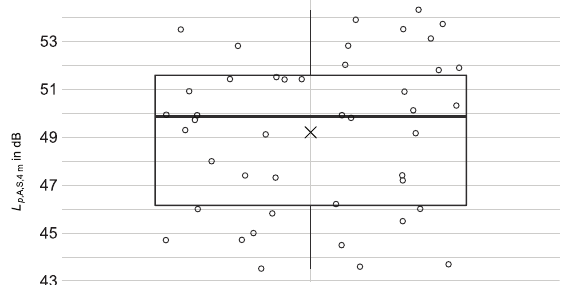
Figure 2. Boxplot representation of all 44 measurement path results for L p ,A,S,4m . The individual measurement results are indicated as circles, the mean value is represented by x .